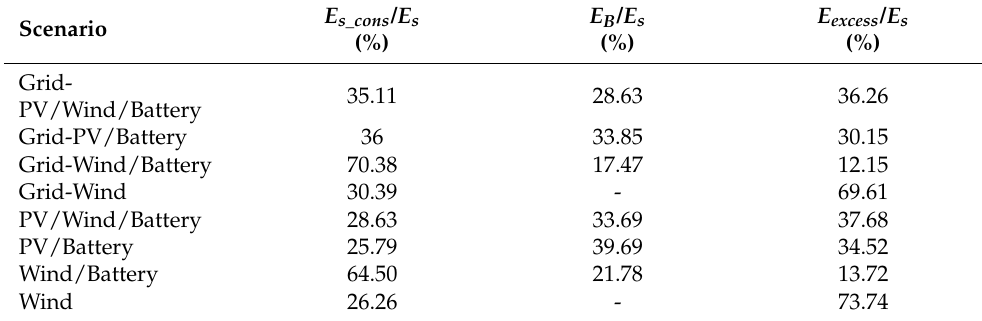
Table 7. Energy supply distribution.